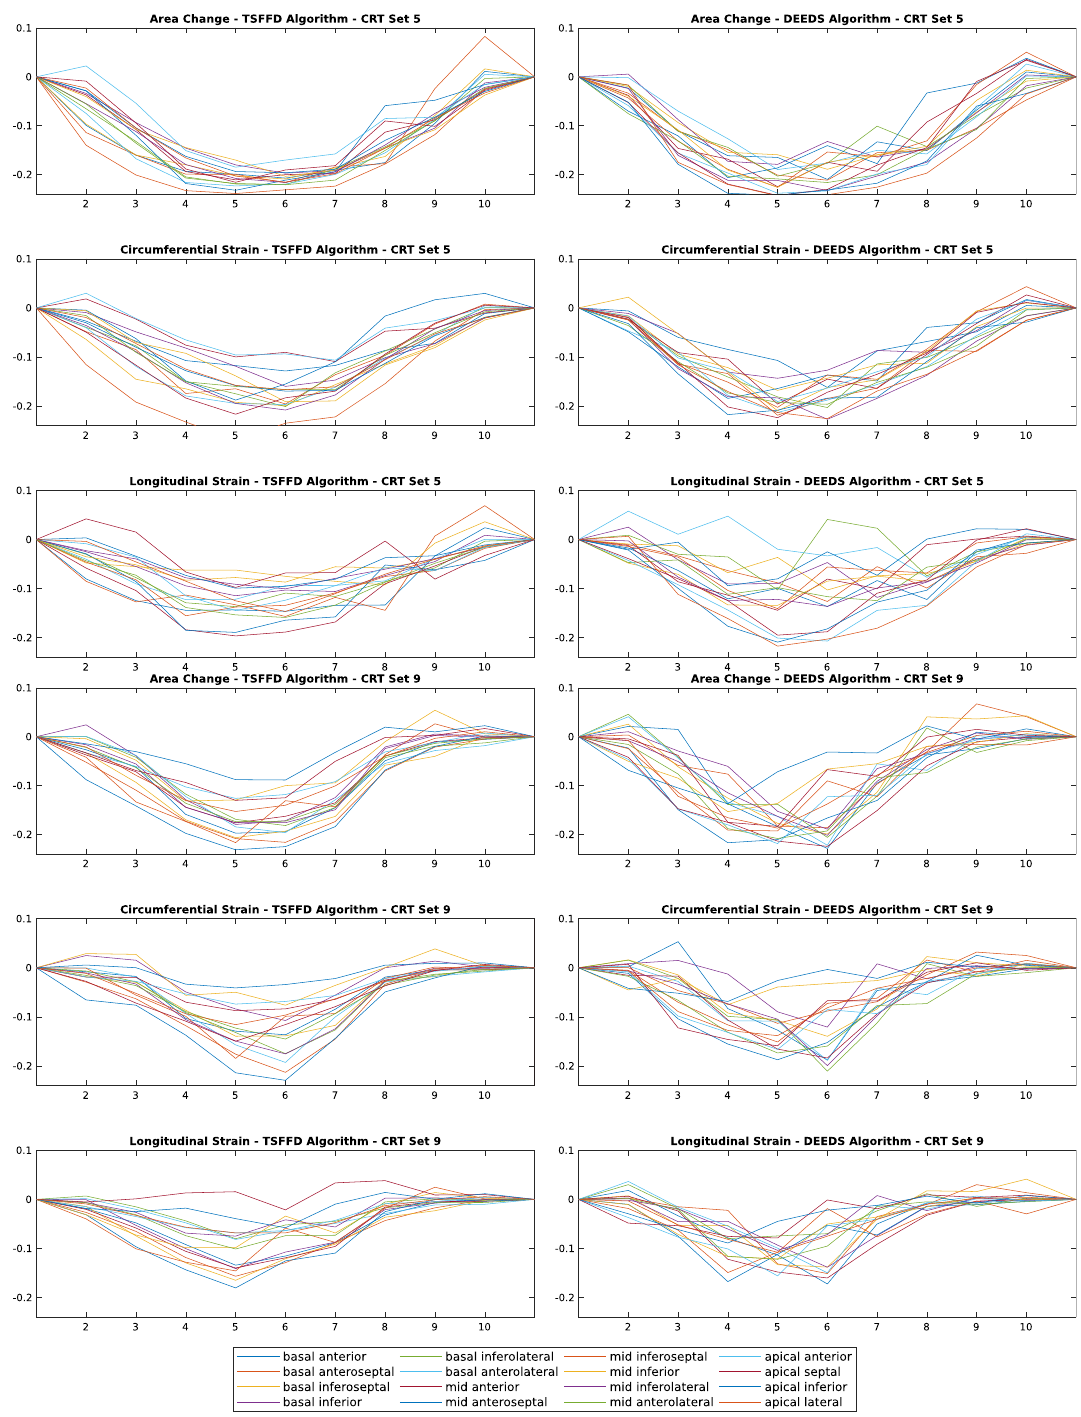
Figure 6. Example of three strains (area, circumferential, longitudinal) calculated from representative CRT datasets. Results from TSFFD and DEEDS are presented on the left and right columns, respectively. X axis displays the temporal frame in the cardiac cycle and Y axis is the calculated